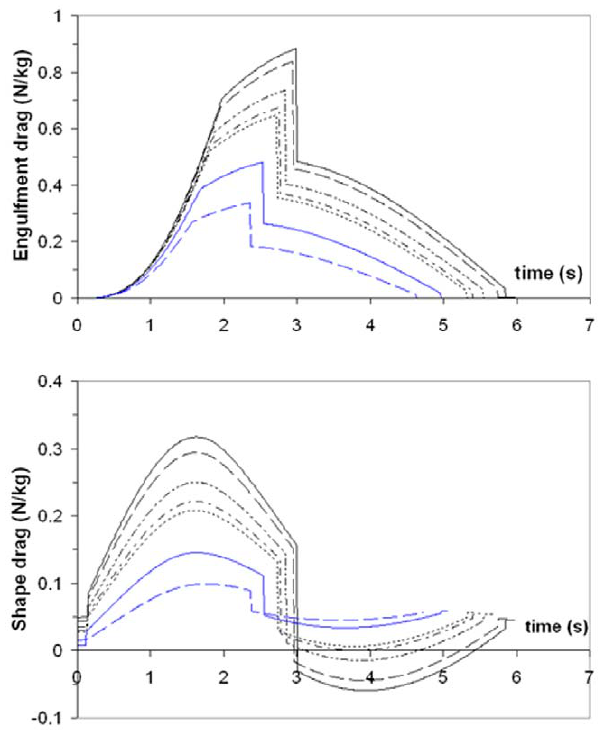
Figure 15. Simulated engulfment (top) and shape drag (bottom) by fin whales (mass-specific). Temporal development at various body lengths: 24.0 m (black, continuous), 22.7 m (black, dashed), 20.2 m (black, dashed-doubly-dotted), 18.5 m (black, dashed- dotted), 17.7 m (black, dotted), 13.5 m (blue, continuous), 10.0 m (blue, dashed).